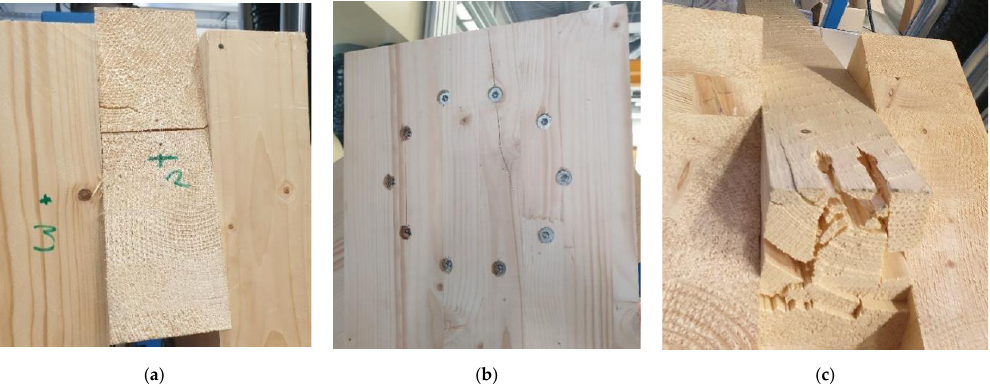
Figure 14. Experiment B: ( a ) failure without reinforced segments; ( b ) reinforcement with reinforced rung; and ( c ) breach with reinforced crossbeam and struts (stands). Buildings 2022 , 12 , x FOR PEER REVIEW